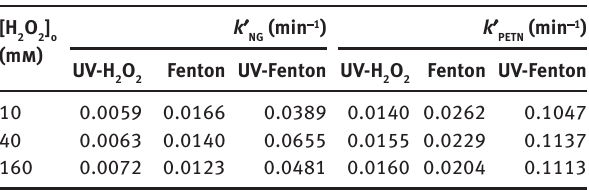
O concentration on the degradation of NG 2 2